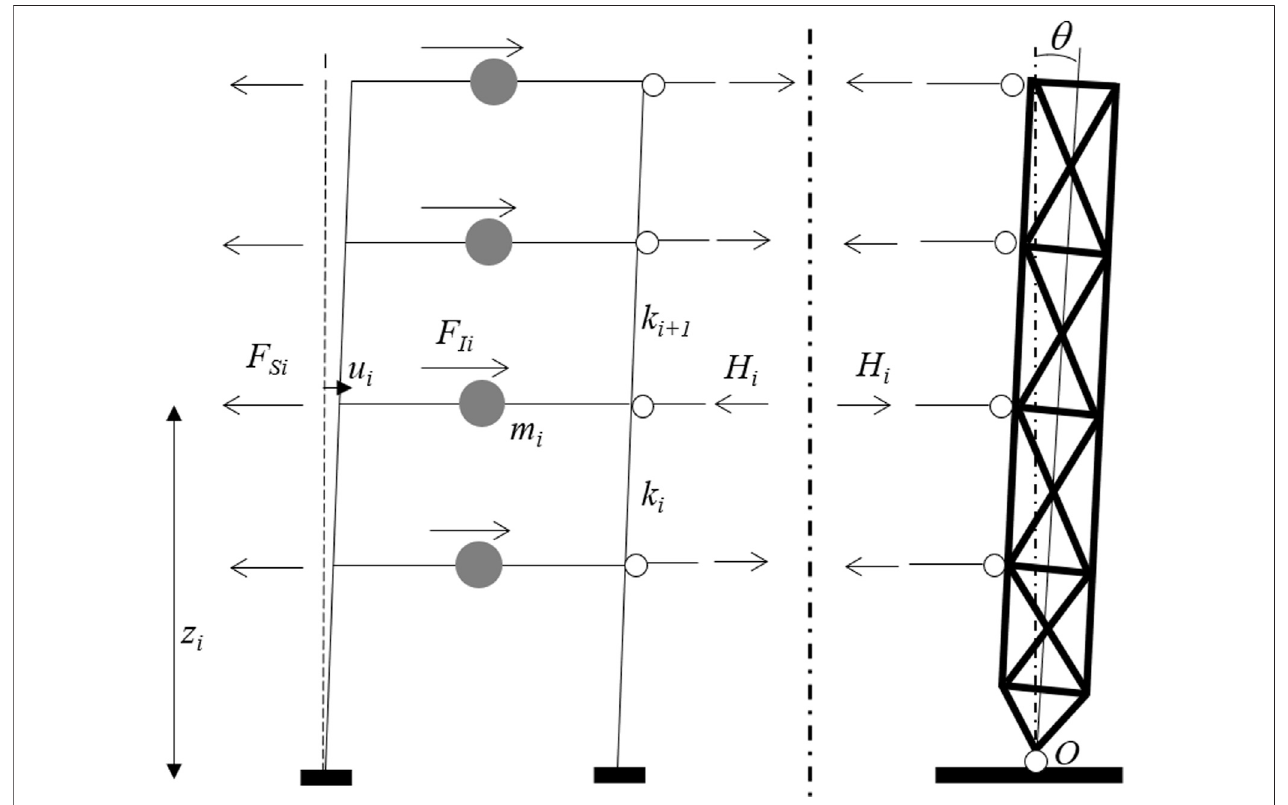
FIGURE 2 | Dynamic forces acting on the undamped frame and on the